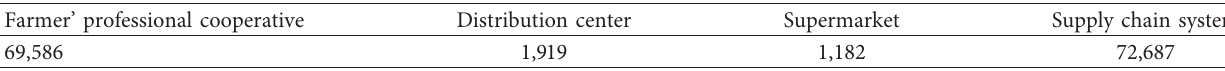
Table 6: Results of the total profit.